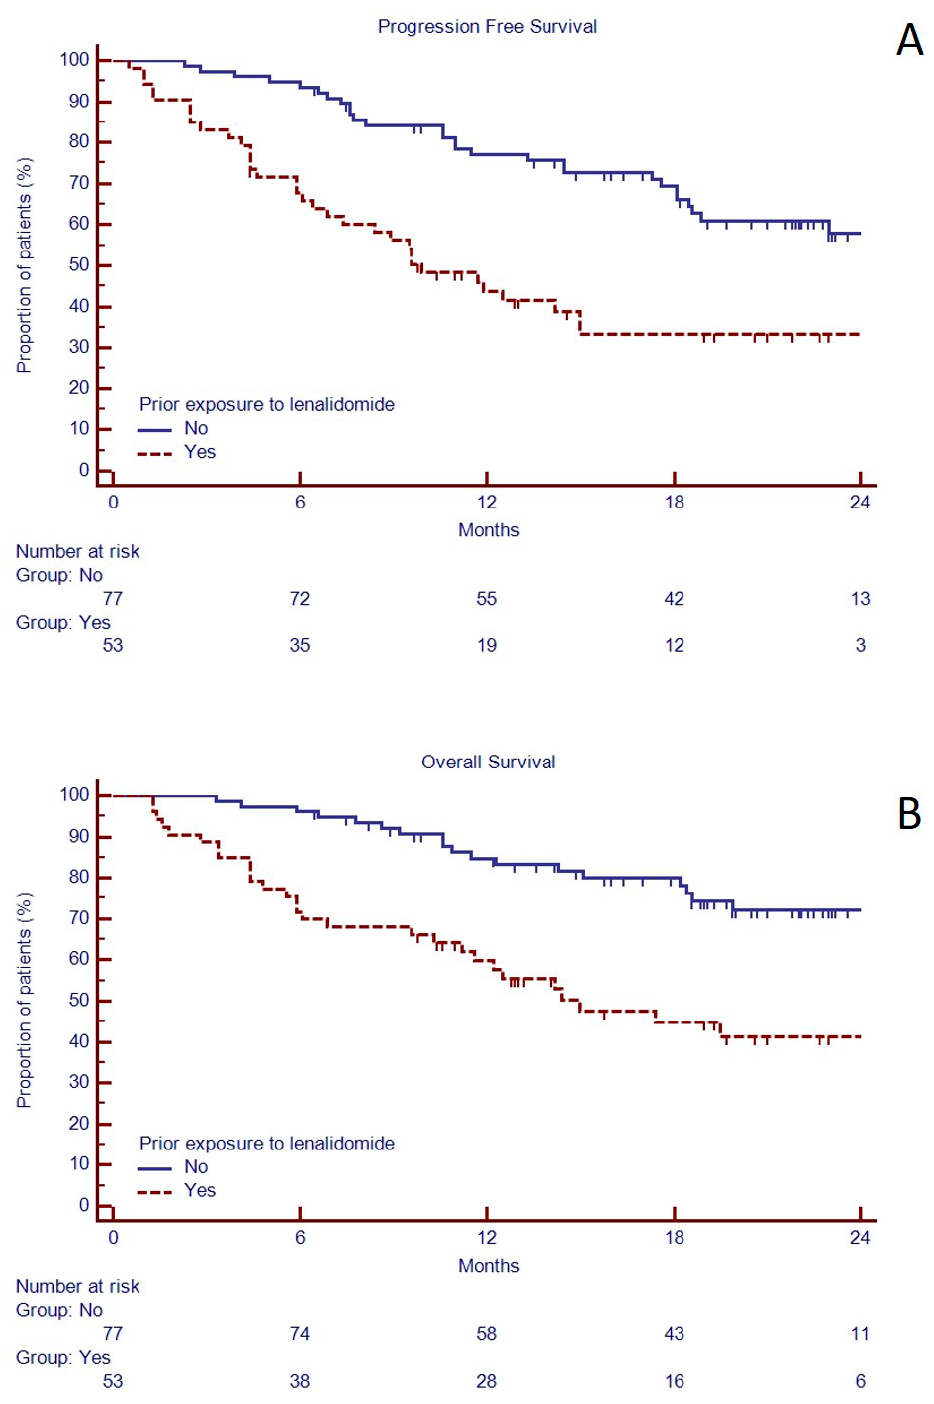
Figure 4. Progression free survival ( A ) and overall survival ( B ) based on creatinine clearance in 130 RRMM candidates to KRd as salvage regimen in a real-life